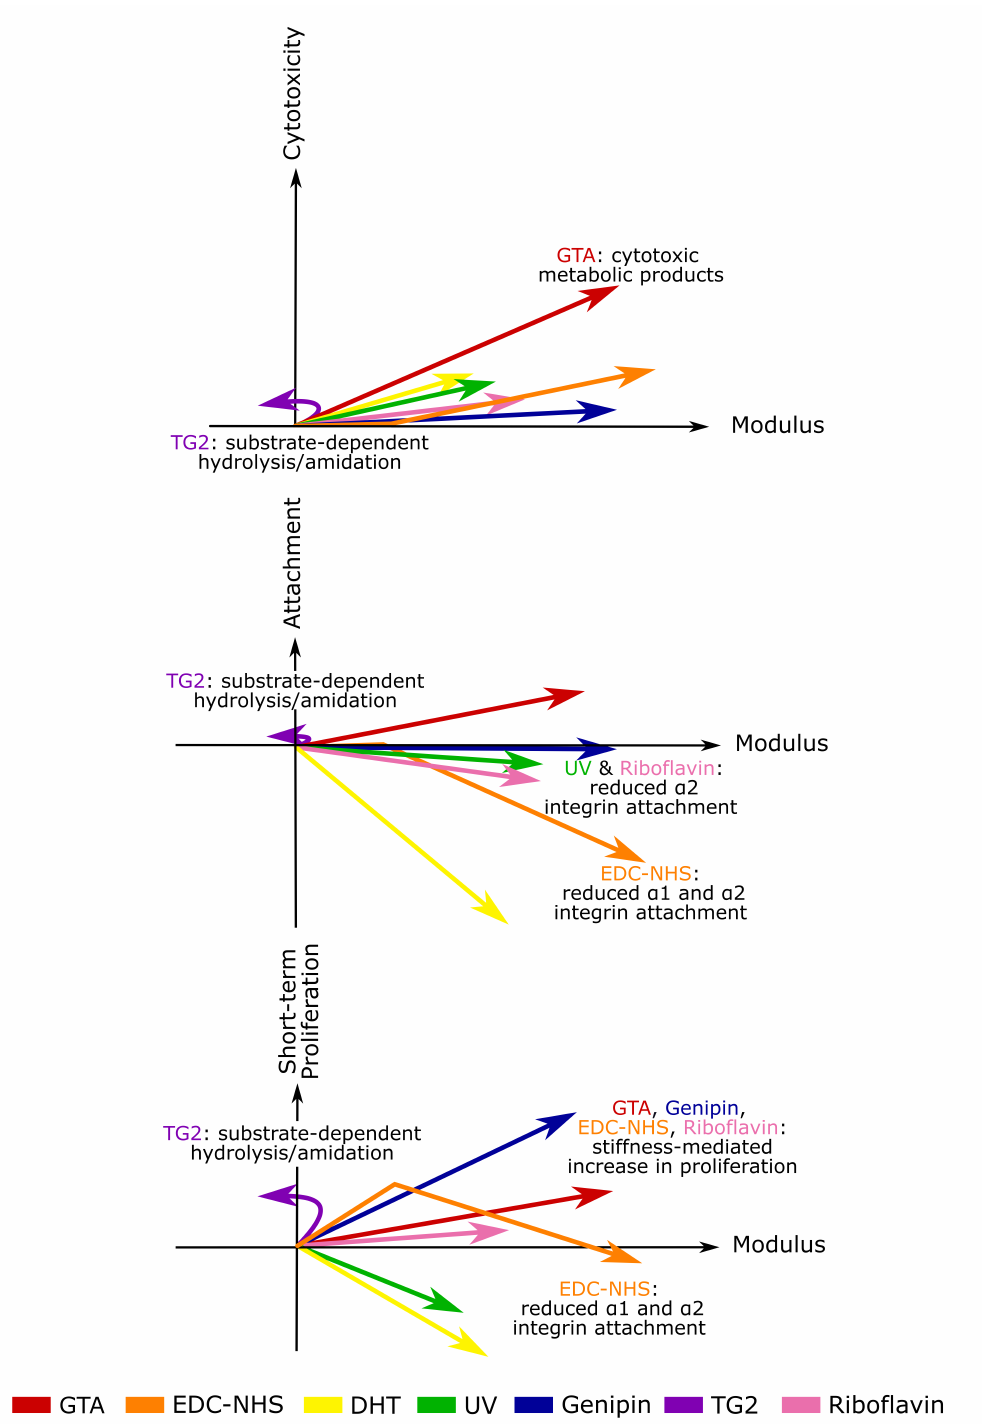
Figure 7. A schematic bioactivity-mechanics materials selection map illustrating a representation of crosslinked or treated collagen substrates in terms of two commonly desired characteristics. The origin represents the behaviour of native uncrosslinked collagen constructs, and the behaviour from the origin following the arrows indicate trends observed with increasing crosslinking concentration. These trends are illustrative of the behaviours observed in studies containing systematic comparisons of collagen crosslinkers, but do not contain exact values and scales since there is significant variability in the types of constructs, cell lines and measurement methods